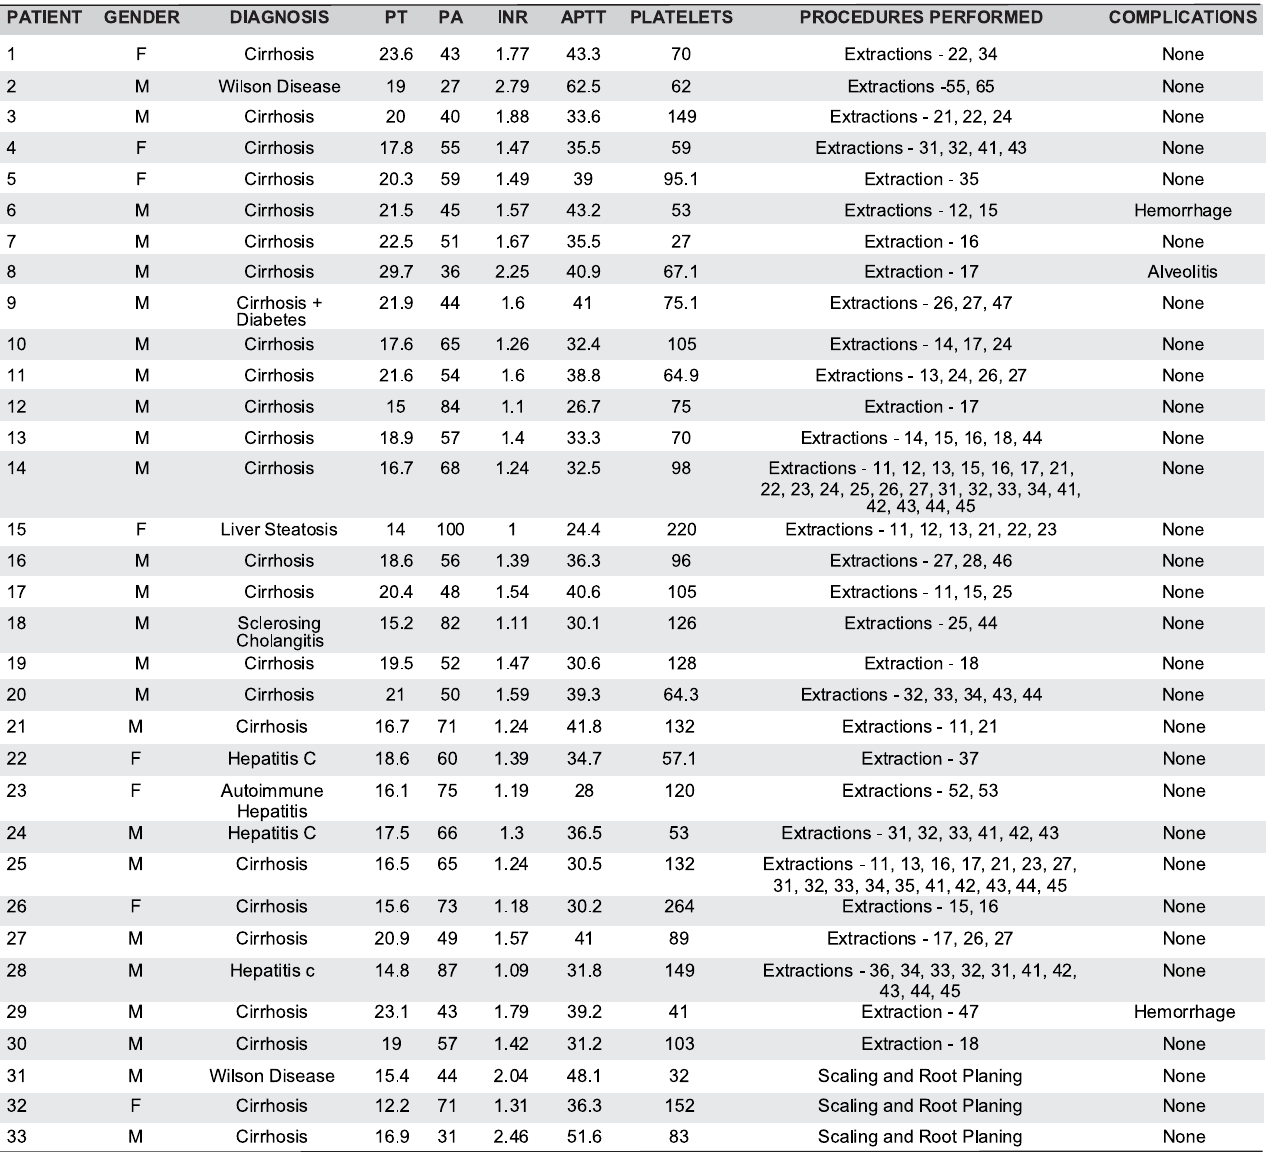
Table 1 - Data from the gender, diagnosis and laboratory evaluation of liver transplant candidates, and total procedures and complications during the dental